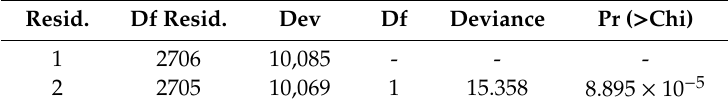
Table 15. Comparison of the variables camera type and contrast ratio by ANOVA. Resid.